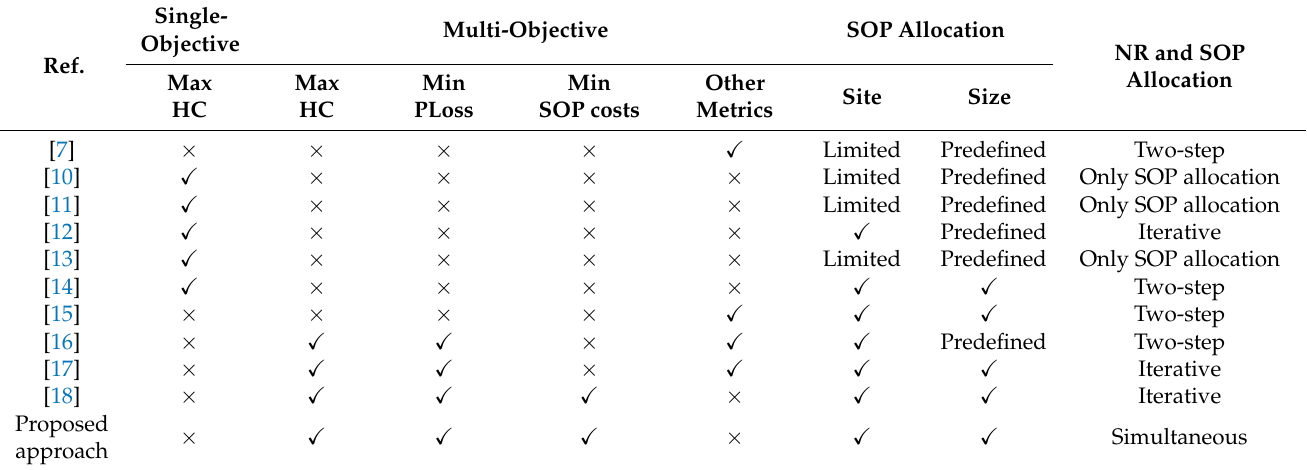
Table 1. Summary of the previous single- and multi-objective optimization